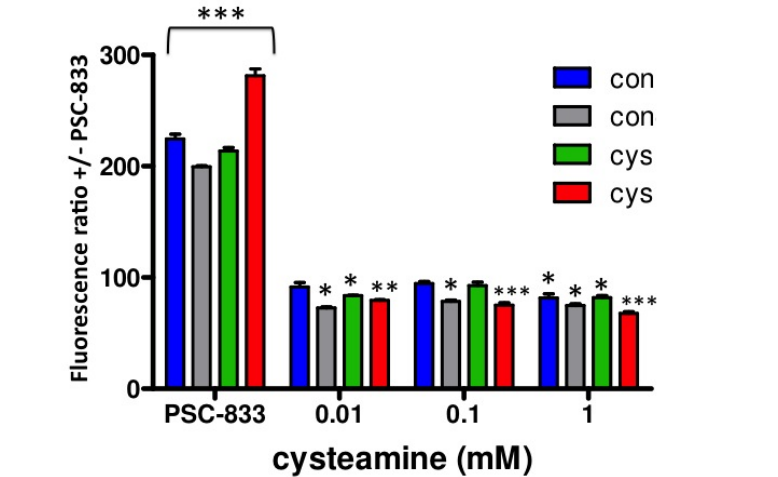
Figure 4. Cysteamine effect on relative P-gp activity. P-gp activity in control (blue and grey bar; n = 2) and in cystinotic ciPTEC (green and red bar; n = 2) was determined after loading the cells with 1 μ M calcein-AM for 60 min either in the presence of the P-gp inhibitory compound PSC833 (5 μ M), or cysteamine (0.01–1 mM). Relative P-gp activity is depicted as ratio of P-gp inhibition (PSC833) over the control condition (vehicle; 0.1% DMSO). Ratio > 100% indicates inhibition of P-gp activity, whereas a ratio < 100% defines increased P-gp activity. Con = control ciPTEC; Cys = cystinotic ciPTEC. * p < 0.05; ** p < 0.01; *** p < 0.001 vs. vehicle treated